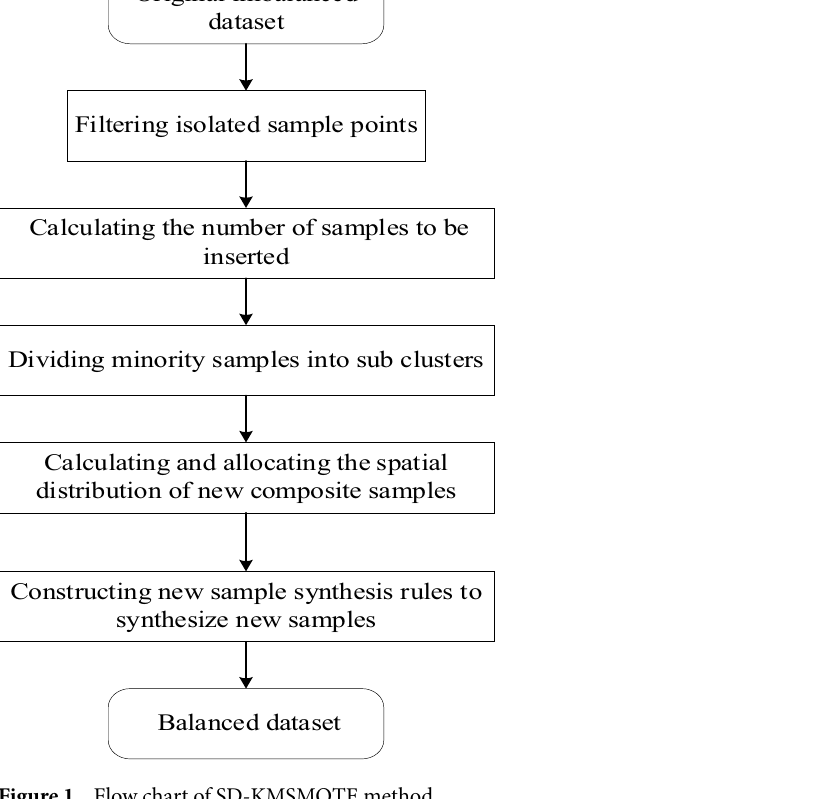
Figure 1. Flow chart of SD-KMSMOTE